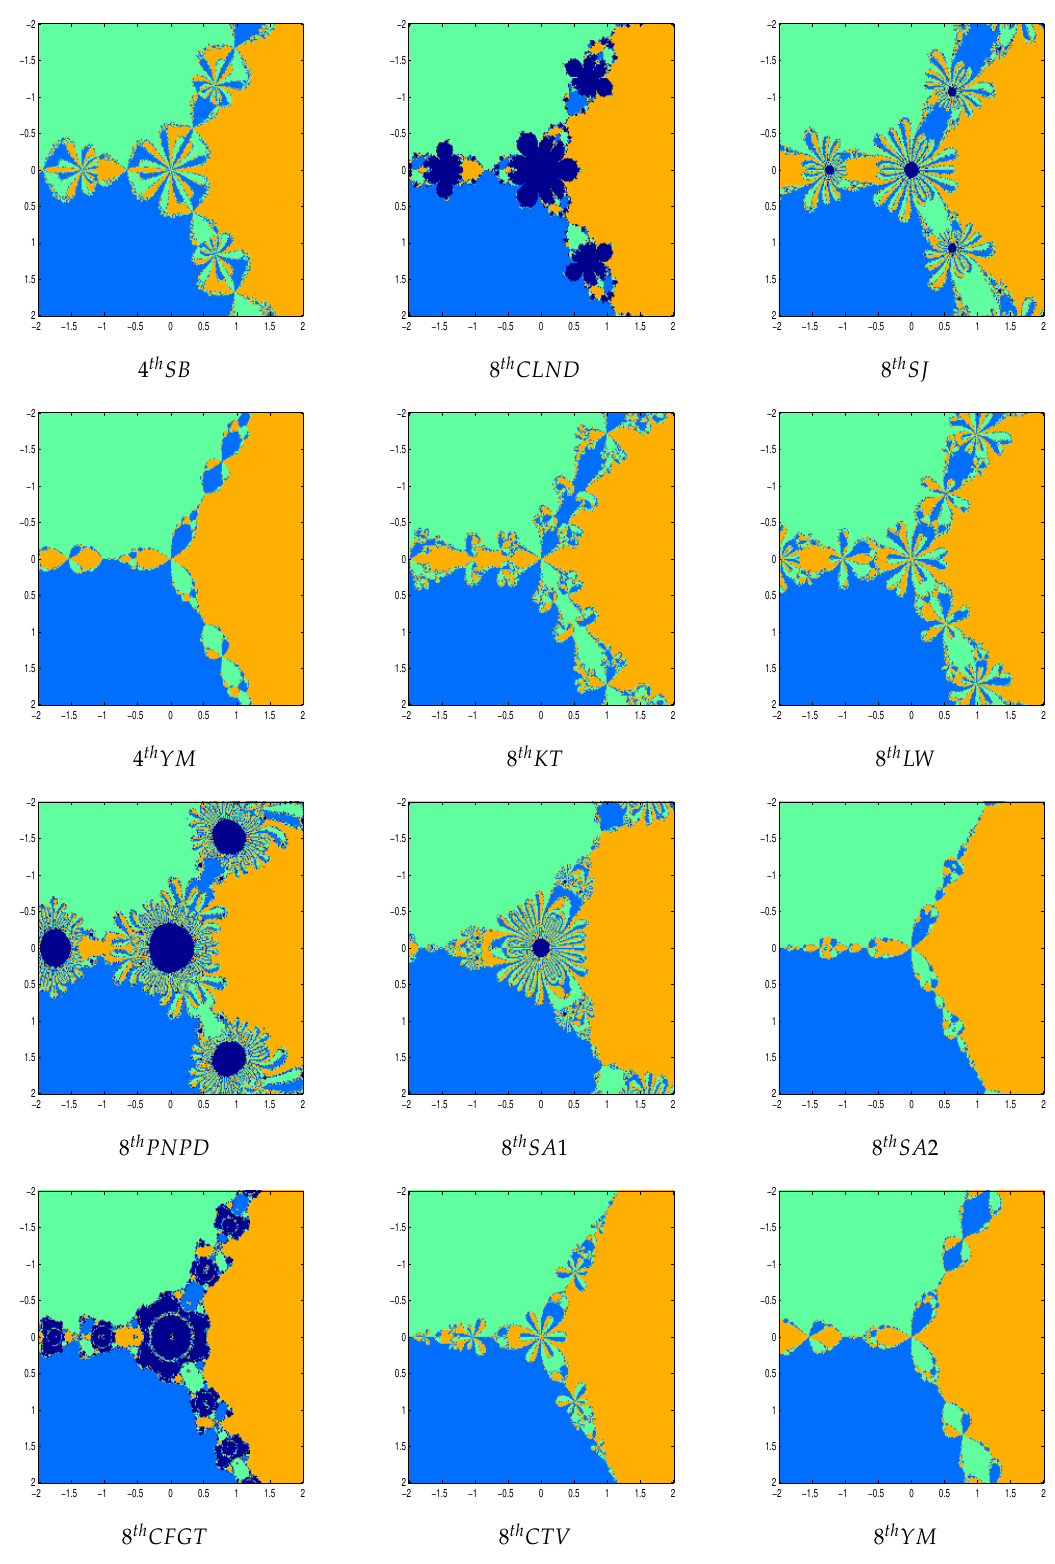
Figure 4. Basins of attraction for p 2 ( z ) = z 3 −